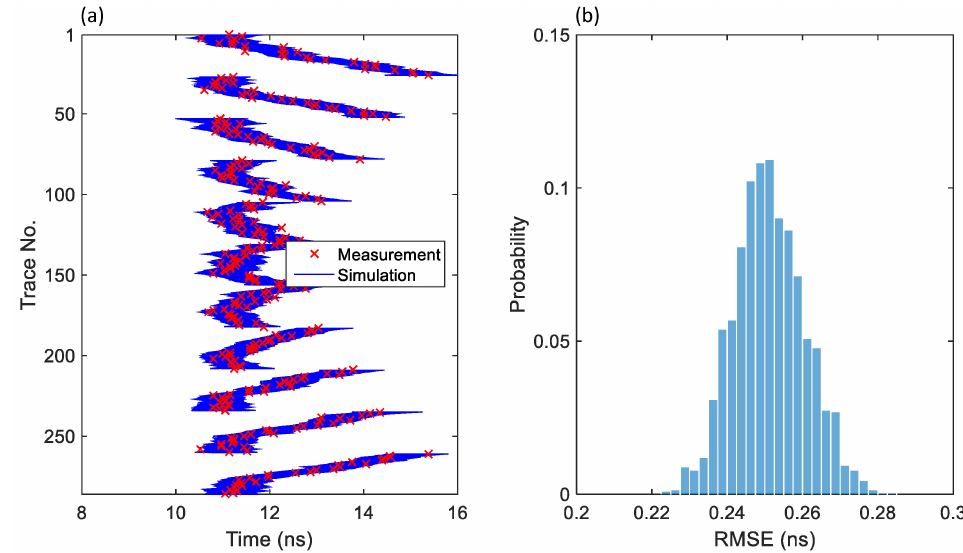
Figure 4. Fitting of the measurement data by the posterior models derived from Bayesian inversion using the straight-ray forward model: ( a ) measured and simulated first-arrival traveltimes, and ( b ) histogram of the root mean squared error (RMSE) values of the posterior solutions.